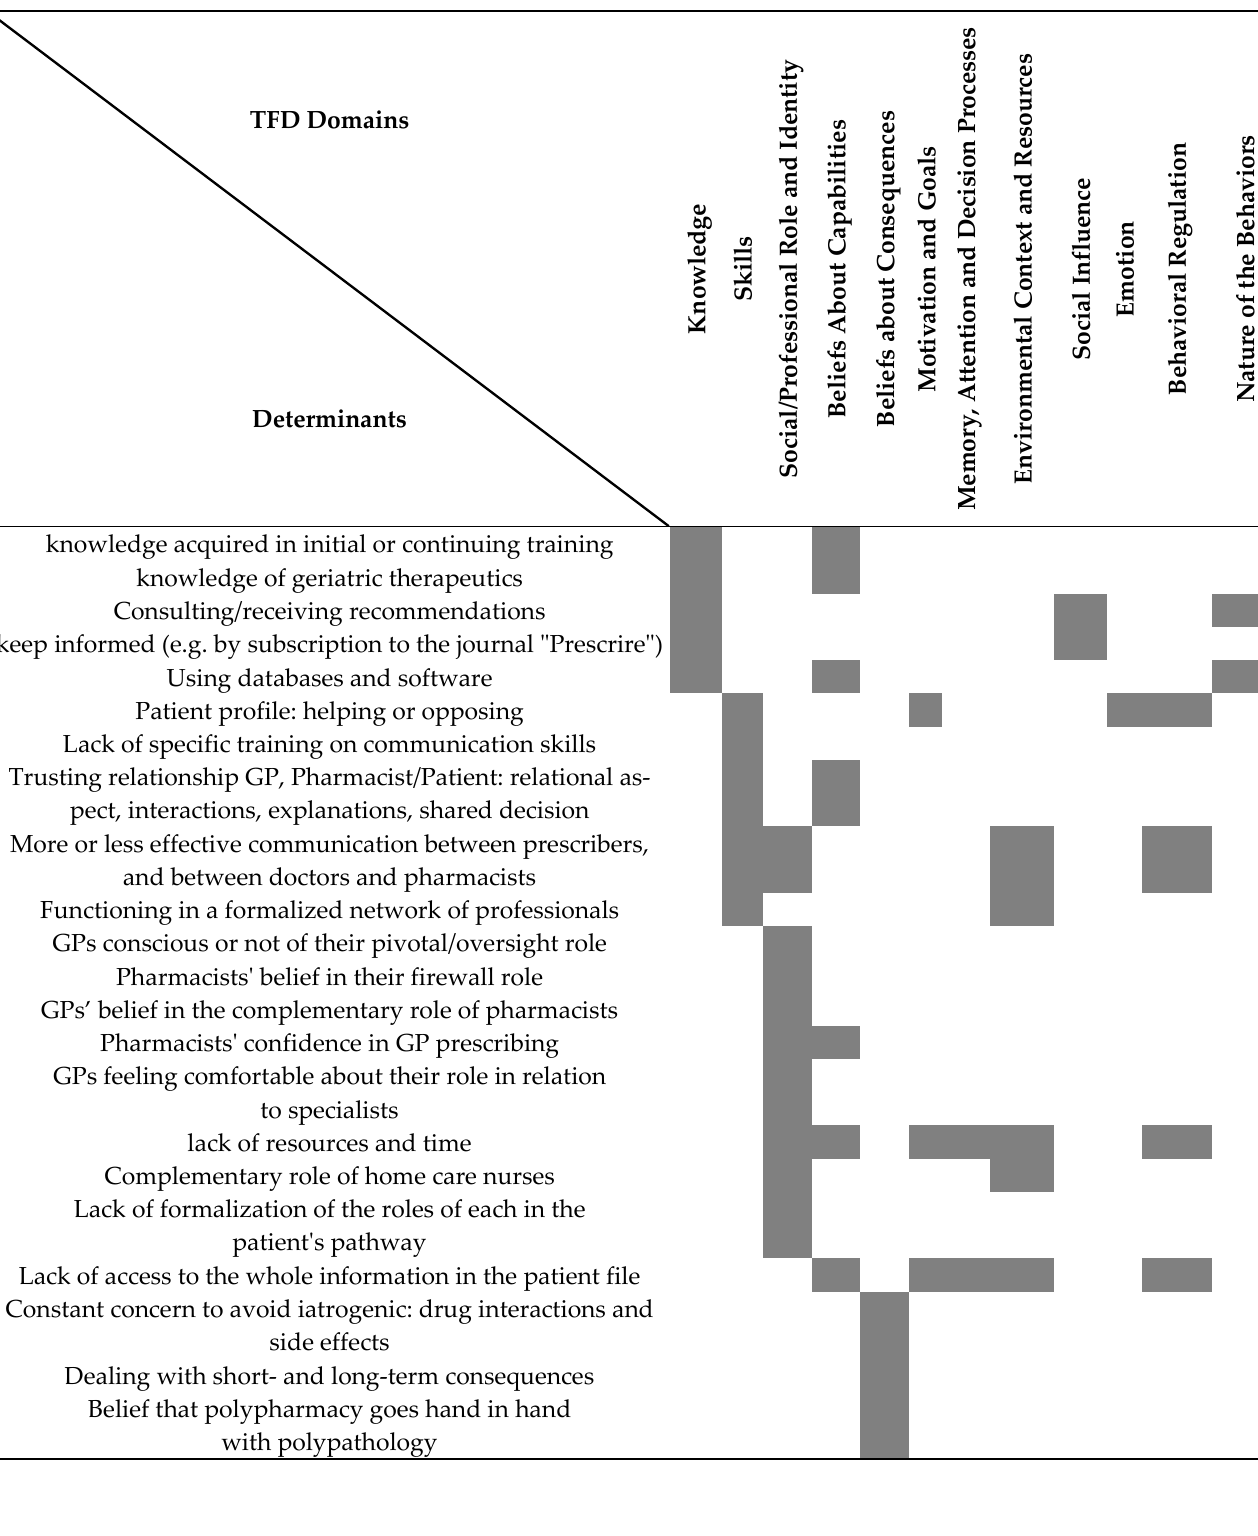
Table 3. Identified determinants (i.e., barriers and/or facilitators) of general practitioners’ and community pharmacists’ behaviors. grey boxes simply indicate: factor identified as having an influence on the TDF domain.